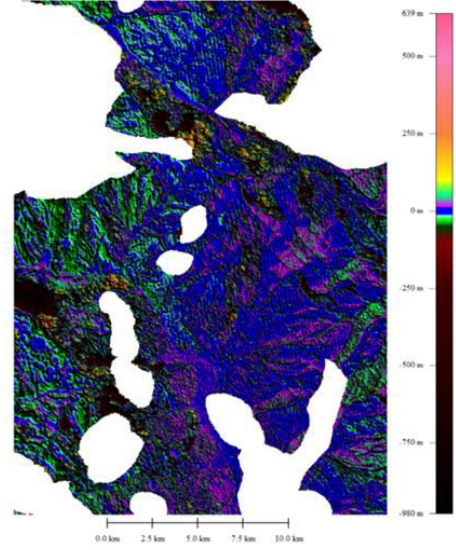
Figure 6: Difference images (ADS80-SRTM X band DEM)